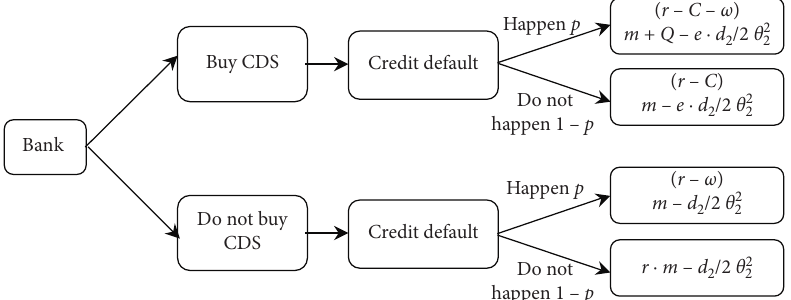
Figure 2: Game expansion of bank selection strategy.